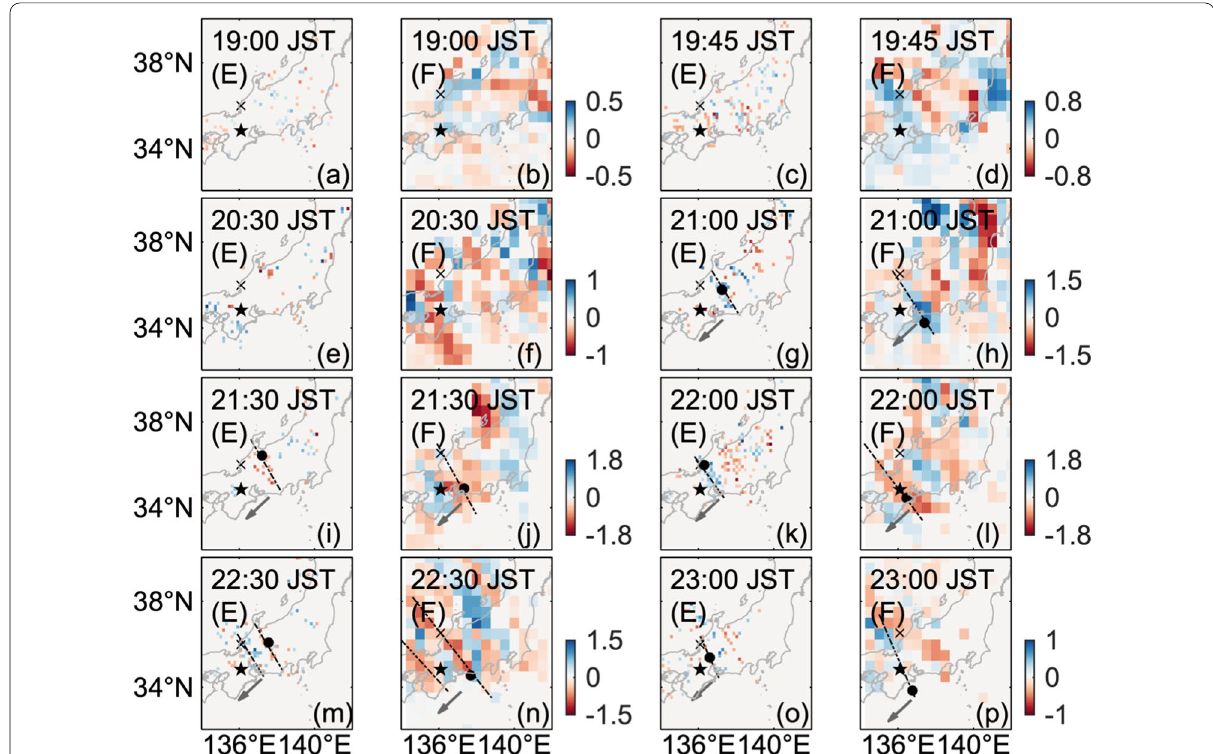
Fig. 9 Same as Fig. 6 but for 11 June 2007 (DOY 162). Black stars are the location of MUR, black crosses represent the observation regions with an altitude of 100 km (E region) and 300 km (F region), where the transmission beam was pointed to the north (azimuth: 0 ◦ , zenith: 52.07 ◦ and 57.84 ◦ in E and F regions, respectively), black dots indicate denote the locations at E (100 km) and F shells (300 km) connected by a geomagnetic field